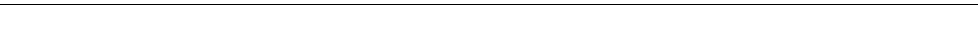
Figura 2 . Prodger 2 Equação para o cálculo do escore geral de produtividade dos últimos cinco anos (CNPq,